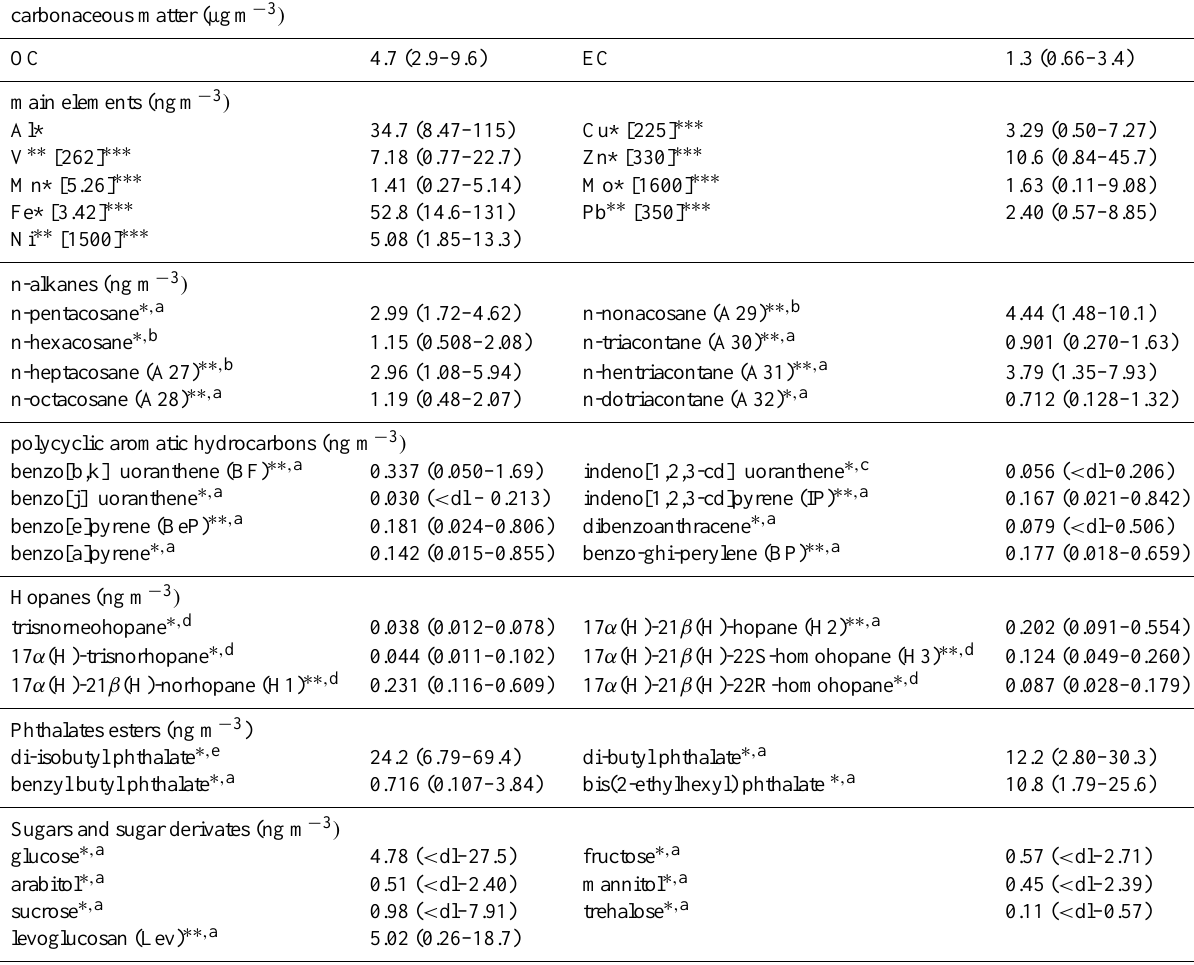
Table 1. Organic and elemental carbon (µgm − 3 ) , main elements (ng m − 3 ) and organic marker concentrations (ngm − 3 ) in PM 2 . 5 (average